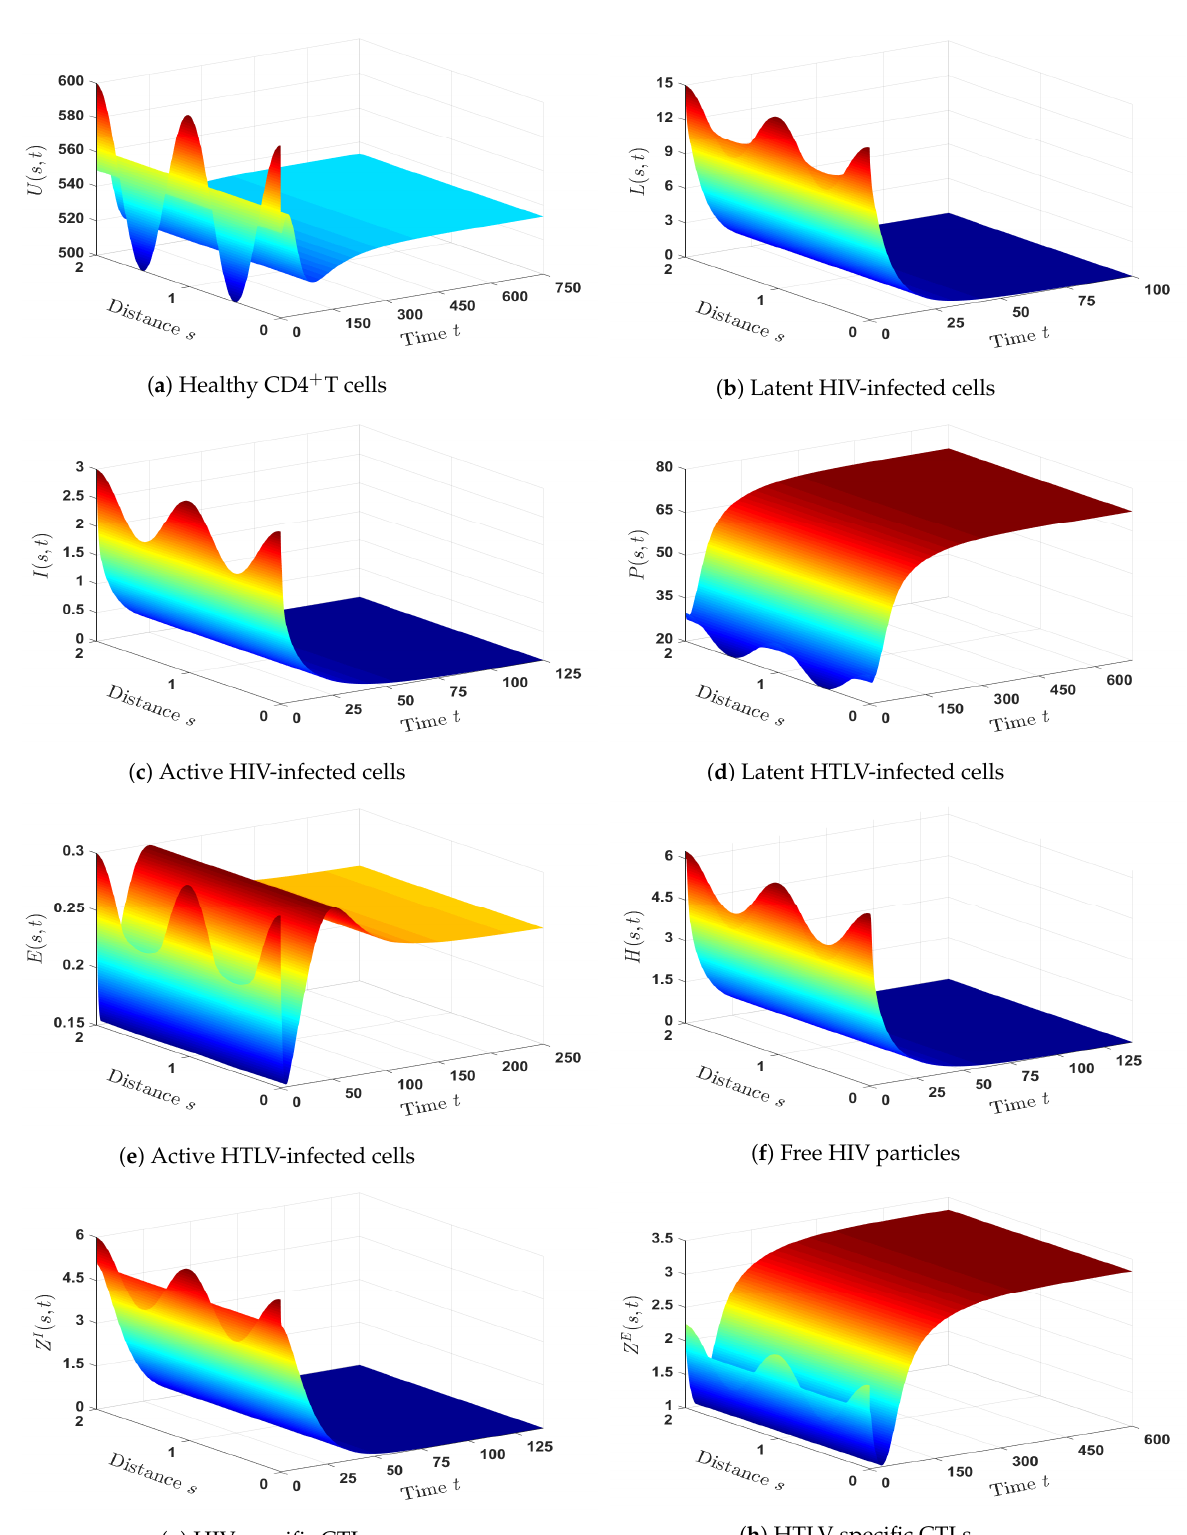
Figure 5. The solution behavior of Model (1) with the initial conditions (26) and boundary conditions (27). Taking ω 1 = ω 2 = 0.0001, ω 3 = 0.0002, ω 4 = 0.035, υ 1 = 0.05, υ 2 = 0.4, we have R 4 = 4.35 > 1, R 6 = 0.68 < 1, and the equilibrium ˇ S 4 = ( 533.33,0,0,71.93,0.25,0,0,3.32 ) is asymptotically